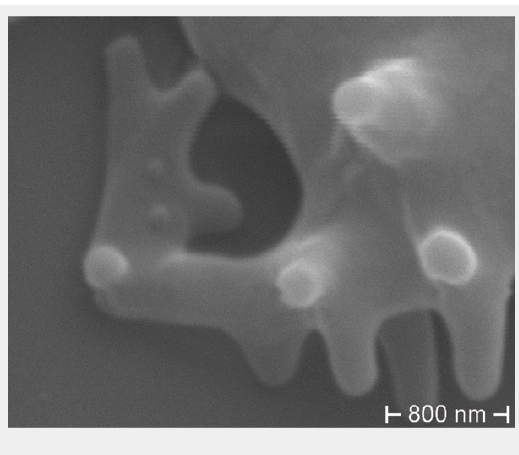
ChAc: schizocyte (S), acanthocytes (A) and echinocytes (E) in